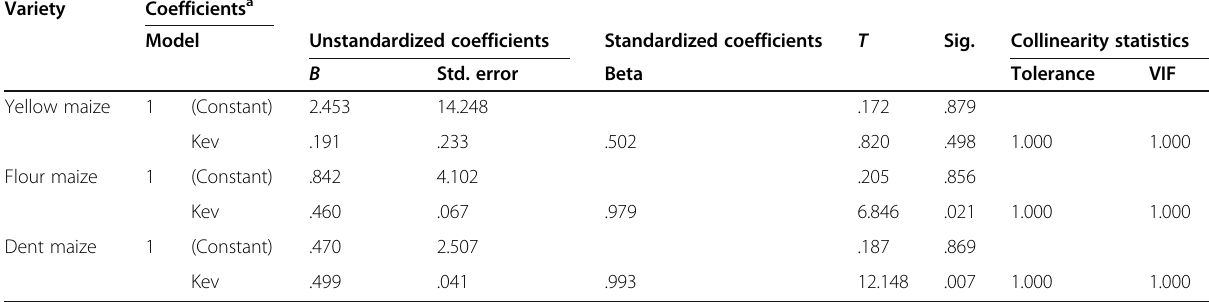
Table 2 Regression coefficients on the yellow maize, flour maize and dent maize varieties for effect of X-ray irradiation on the mortality of S . zeamais after 168 h (7 days) of exposure Variety